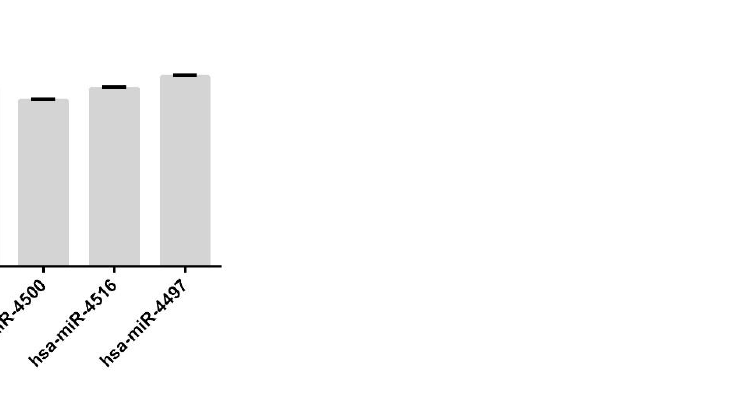
5 of 14 Figure 3. Heatmap: common miRNAs expression profiles in plasma and placenta . Heatmap shows the expression levels of each common miRNA in plasma and placenta tissues. The expression